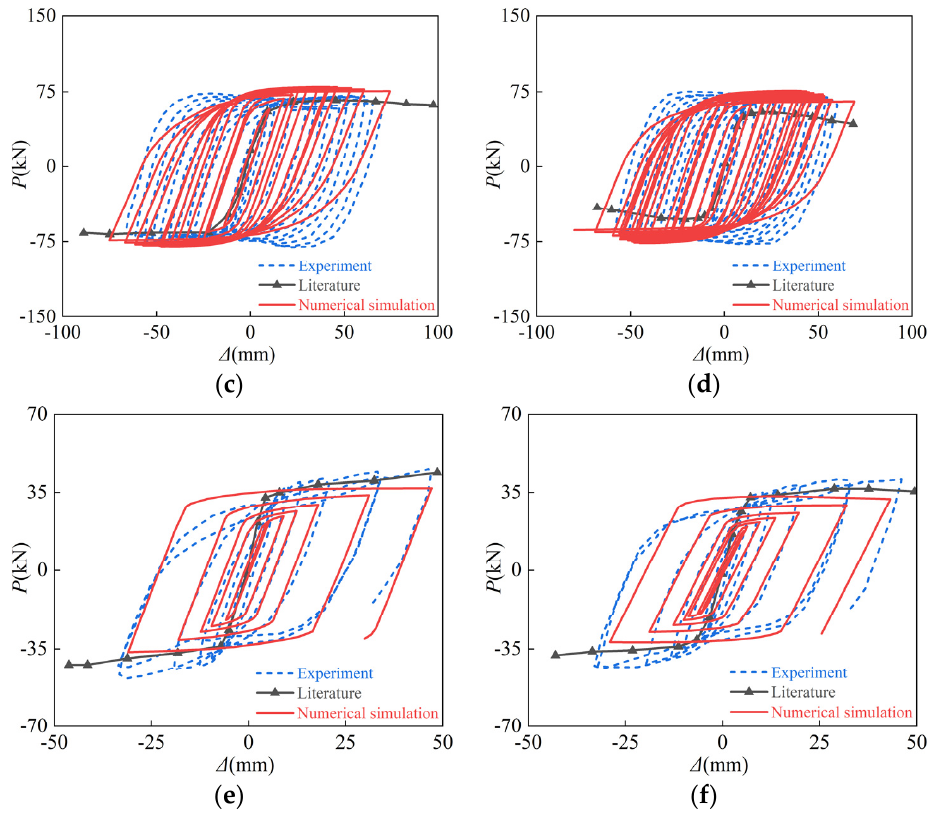
Figure 5. P- Δ hysteresis curves after exposure to fire: ( a ) CF1; ( b ) CF2; ( c ) CF3; ( d ) CF5-1; ( e ) SF1; ( f ) SF2-1.